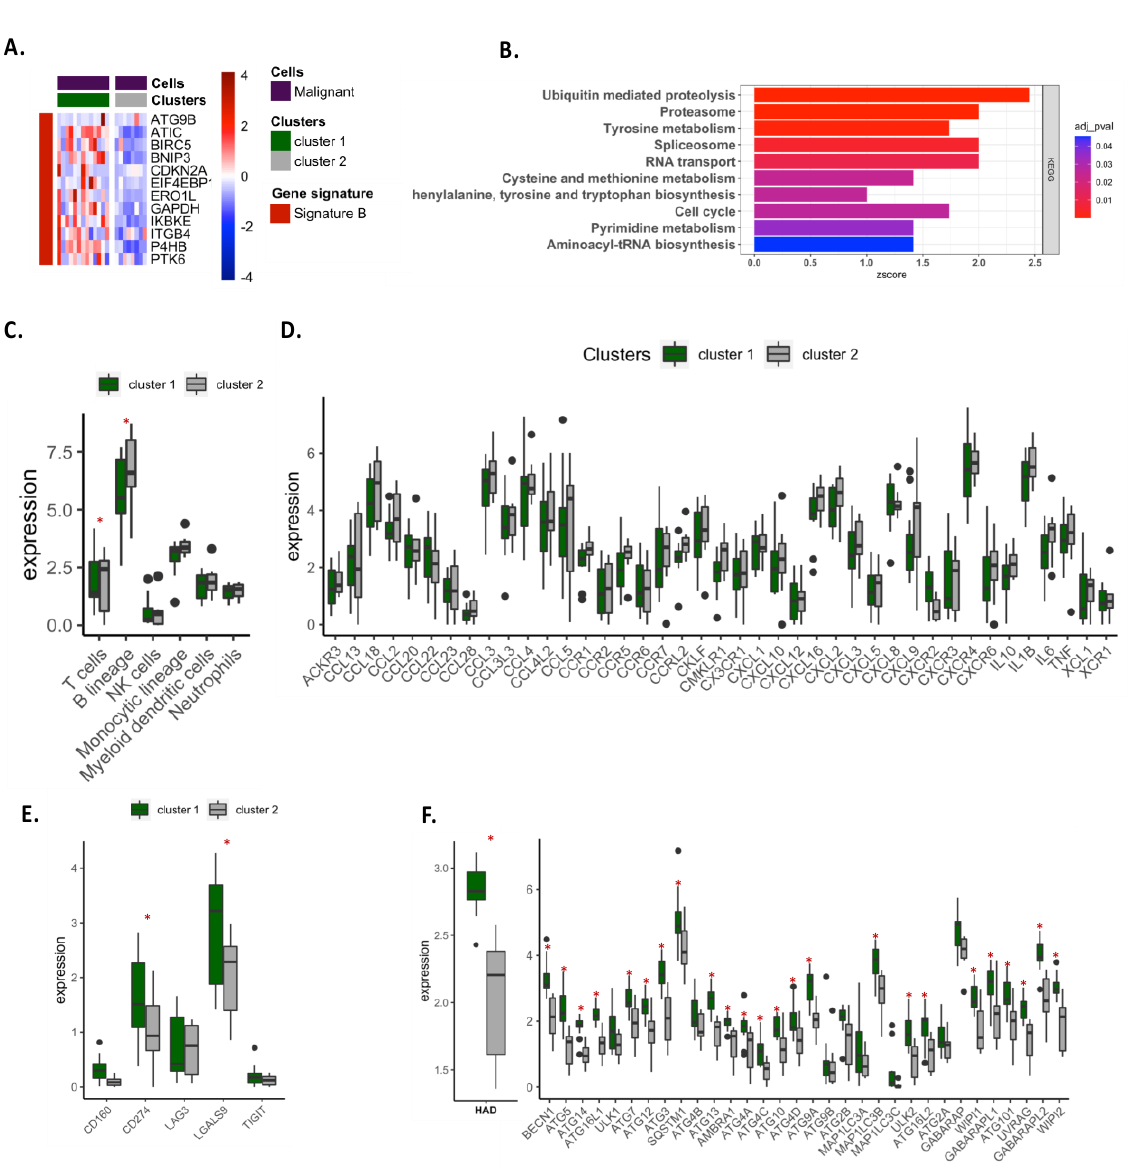
Figure 6. Metabolic and immunologic status of malignant cells according to signature B. ( A ) Unsupervised clustering of patients using autophagy signature B in malignant cells samples using the GSE111907 datasets. ( B ) KEGG enrichment analysis between cluster 1 and cluster 2. ( C – E ) Analyses of immune cell infiltration ( C ), expression of chemokine-related genes ( D ) and expression of genes involved in immune checkpoint ( E ) in clusters. ( F ) Expression of global (human autophagy database) and autophagy genes in the GSE111907 datasets. *, p -value < 0.05.